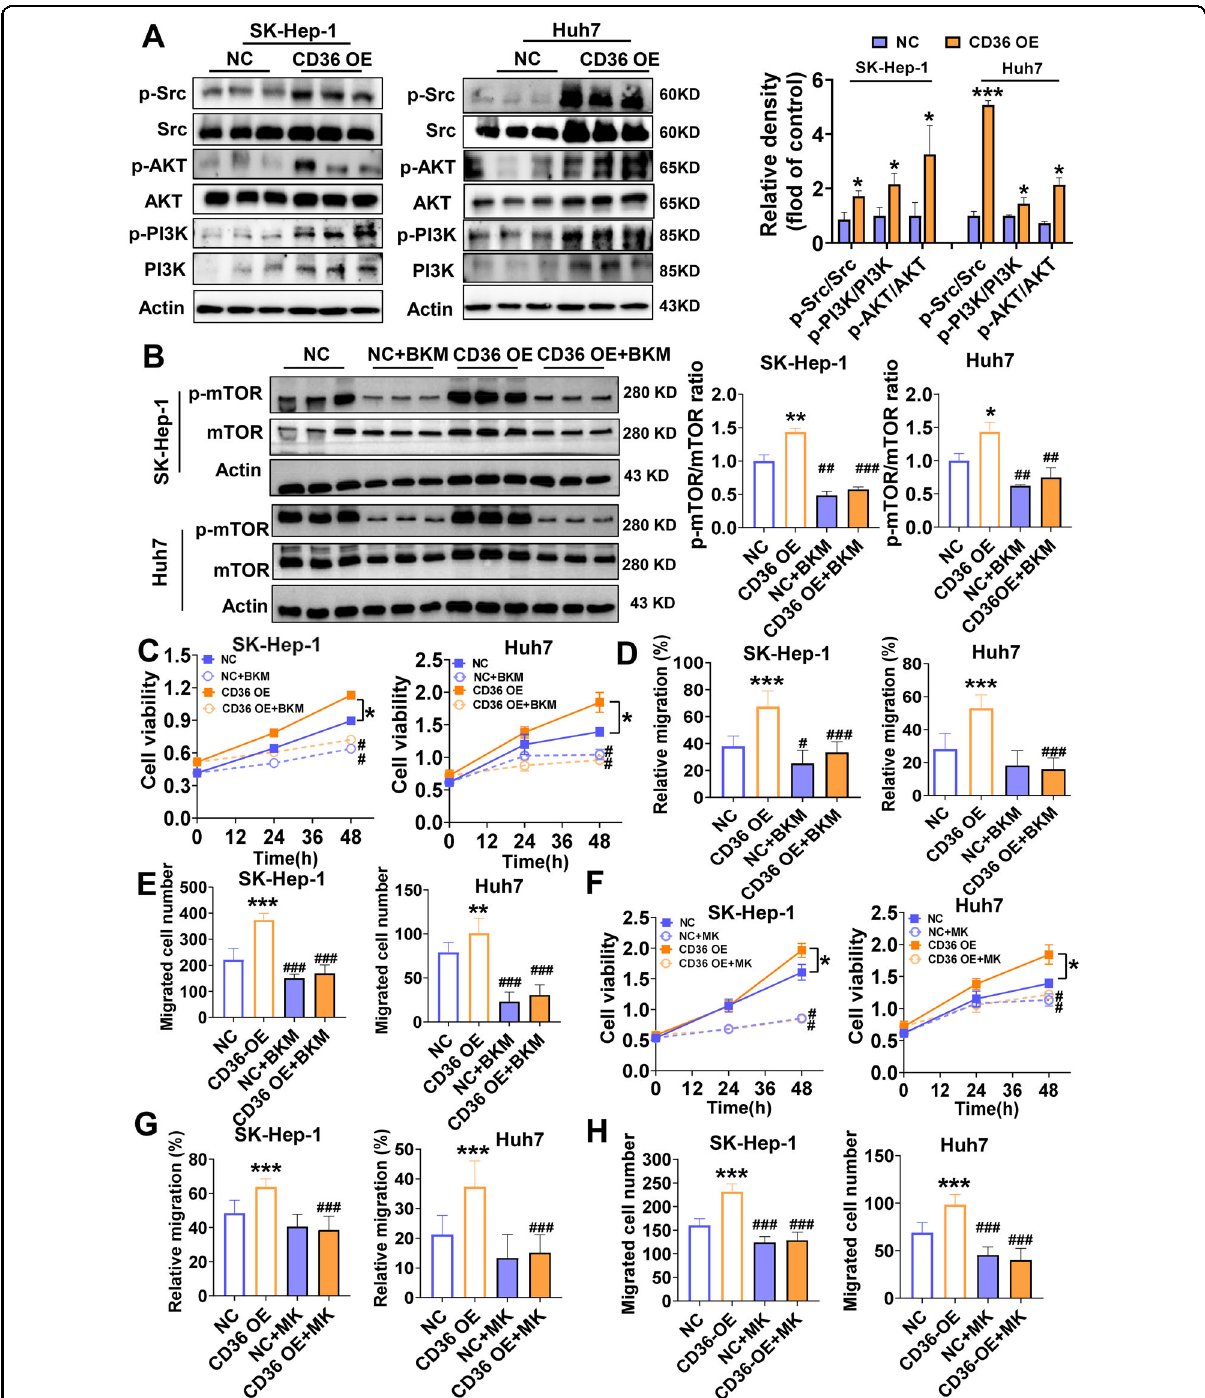
Fig. 7 Src/PI3K/AKT is a key pathway by which CD36 activates mTOR. A Western blot analysis of Src, p-Src (tyr416), AKT, p-AKT (Ser43), PI3K, and p-PI3K expression both in SK-Hep-1 and Huh7 cells ( n = 3). The relative quanti fi cation of the target proteins was shown on the right. B SK-Hep-1 and Huh7 cells were pretreated with BKM-120 (BKM, 1 μ M) before analyzing mTOR signaling pathway ( n = 3). The ratio of p-mTOR/mTOR was shown on the right. C Proliferation of HCC cells treated with or without BKM-120 (1 μ M), an inhibitor of PI3K ( n = 6). Wound-healing ( D ) and transwell assays ( E ) were used to evaluate the migration of HCC cells with or without BKM ( n = 10). F Proliferation of HCC cells treated with or without MK-2206 (MK, 5 μ M), an inhibitor of AKT ( n = 6). Wound-healing ( G ) and transwell assays ( H ) were used to evaluate the migration of HCC cells with or without MK ( n = 10). All data are presented as mean±SD. * P <0.05, ** p <0.01, and *** p <0.001 compared with the NC group, # P <0.05, ## P <0.01, and ### p <0.001 compared with the group without BKM or MK. P -value was calculated using Student ’ s t -test ( A ) and one-way analysis of variance with Tukey ’ s multiple comparison tests ( B – H